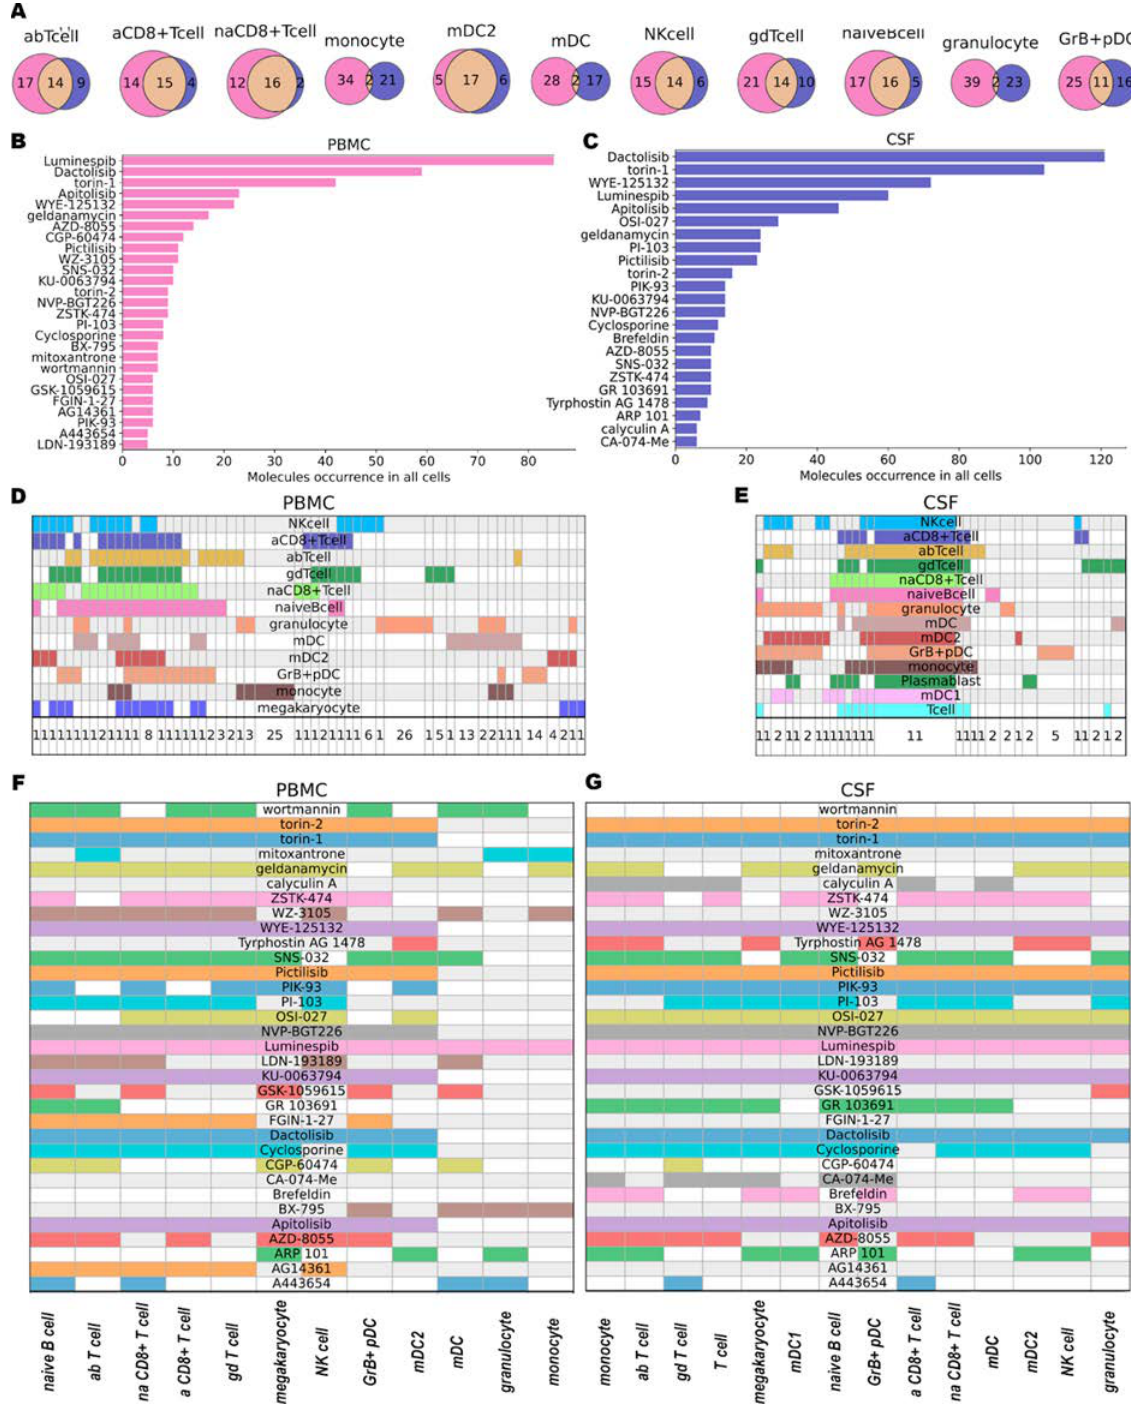
Figure 2. Small molecules results ( A ): Intersections of the same cell types in PBMC (purple) and CSF (blue). ( B , C ): Occurrence of molecules in CSF ( C ) and PBMC ( B ) in all cell types. For visualization, we used only molecules that occur more than five times. ( D , E ): Intersection of agents obtained for each cell type in tissue (PBMC—( D ), CSF—( E ). Each column represents a group of small molecules (their number is provided at the bottom of the plot). Groups were created and sorted based on intersections of small molecules between cell types (rows). ( F , G ): Plots of the occurrence of molecules in the found cell types in PBMC ( F ) and CSF ( G ).